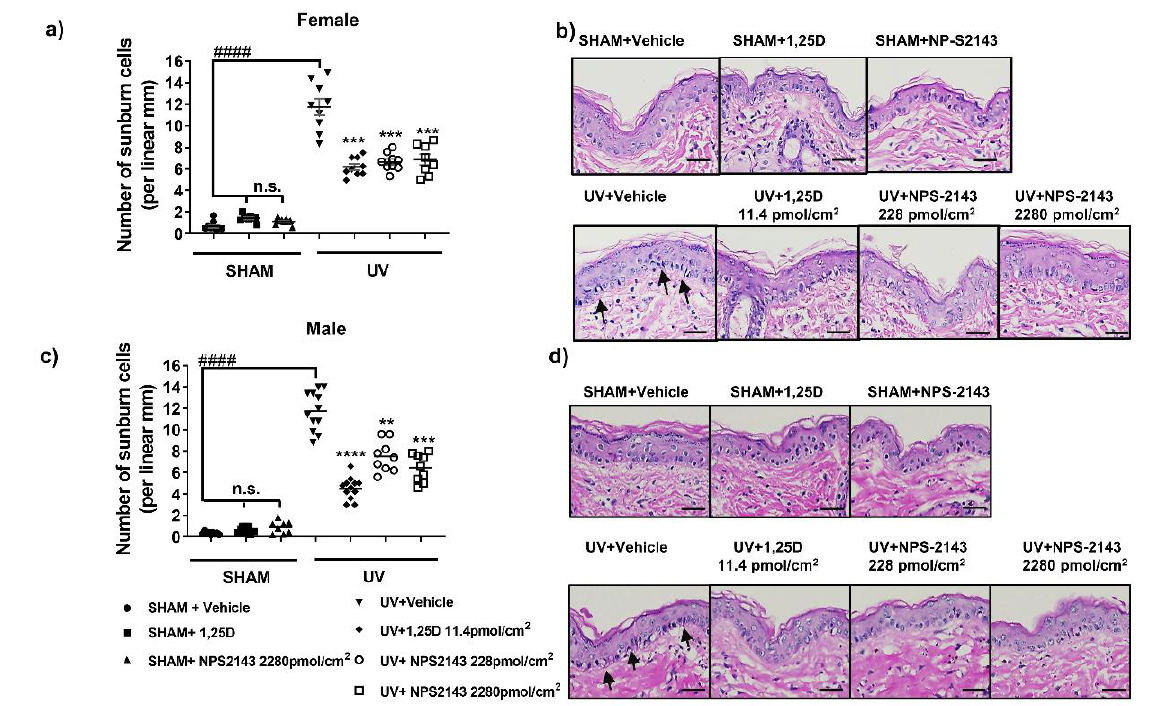
Figure 2. NPS-2143 reduces apoptotic keratinocytes in female and male mouse skin following acute UV irradiation. Immediately after exposure to ssUV, female and male Skh:hr1 mice were treated with vehicle 1,25D (11.4 pmol/cm 2 ) or NPS-2143 (228 or 2280 pmol/cm 2 ) topically, and skin was harvested after 3 h. The number of sunburn cells in female ( a ) and male ( c ) mice is presented as displaying data as dot plots. These graphs show representative data from two individual experiments with similar results on each occasion. **** p < 0.0001, *** p < 0.001, ** p < 0.01, and n.s. not significant compared with UV-vehicle treated group by linear mixed model analysis; #### p < 0.0001 significantly different from UV-vehicle by t -test ( a ): t = 8.417, df = 10 ( c ): t = t = 12.09, df = 14. n = 9 (triplicate biopsies per mice, 3 mice per group). ( b , d ) Photomicrographs of UV-induced sunburn cells in female ( b ) or male ( d ) mice. Arrows show histological appearance of apoptotic sunburn cells in haematoxylin and eosin stained Skh:hr1 mouse skin section with shrunken, elongated nuclei-stained dark purple. Scale bars =100 μm .